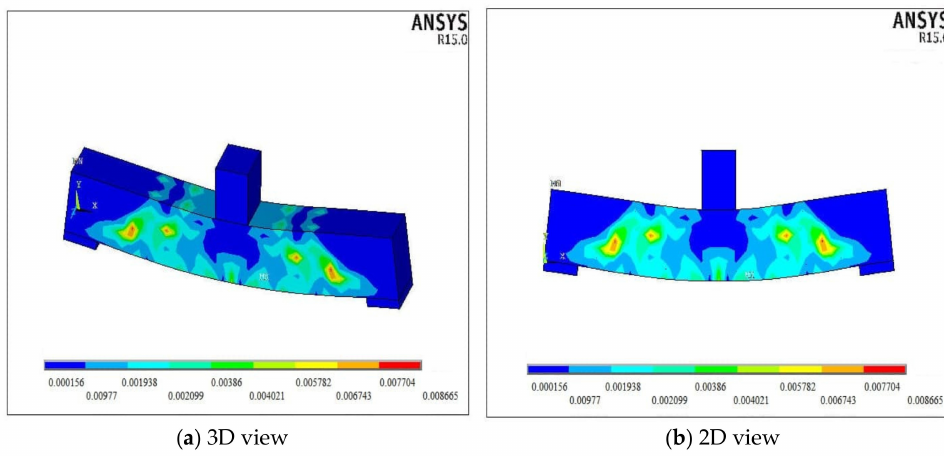
Figure 8. 3D and 2D von Mises strain contours of the control beam model B1 at